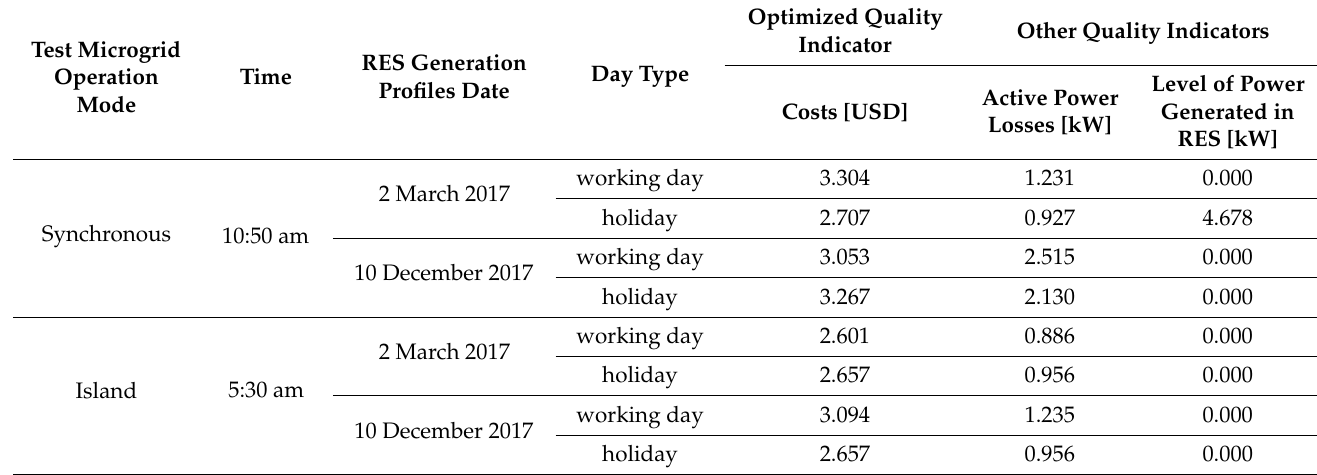
Table 5. Selected results of optimization calculations in task 2.